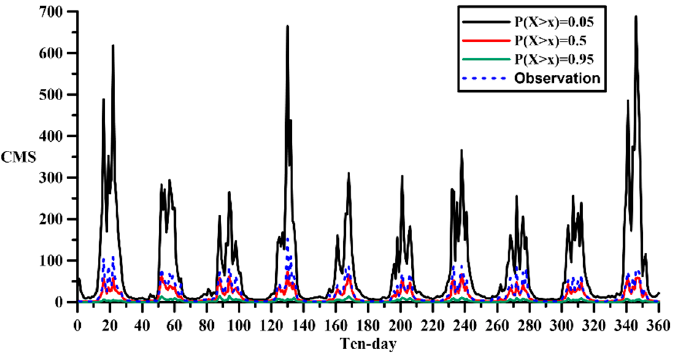
Figure 16. Comparisons of 10-year flow data with Method II.